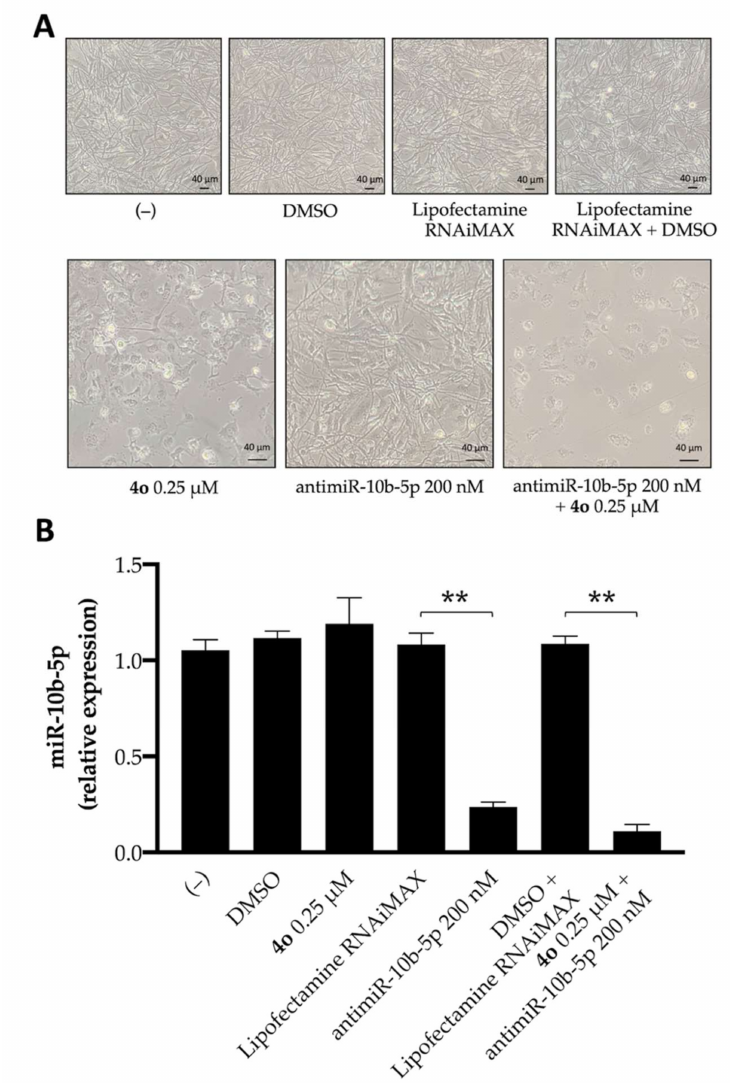
Figure 4. Effects of compound 4o and antimiR-10b-5p on U251 morphology and expression of miR-10b-5p. ( A ). Studies focusing on U251 morphology. ( B ). Effects on miR-10b-5p, analyzed by RT-qPCR. Cells were either untreated ( − ) or treated as indicated for 3 days. In panel B, the results represent miR-10b-5p expression with respect to relatives Lipofectamine and Lipofectamine plus DMSO controls (mean ± SD; n = 3). p < 0.01 (**; highly